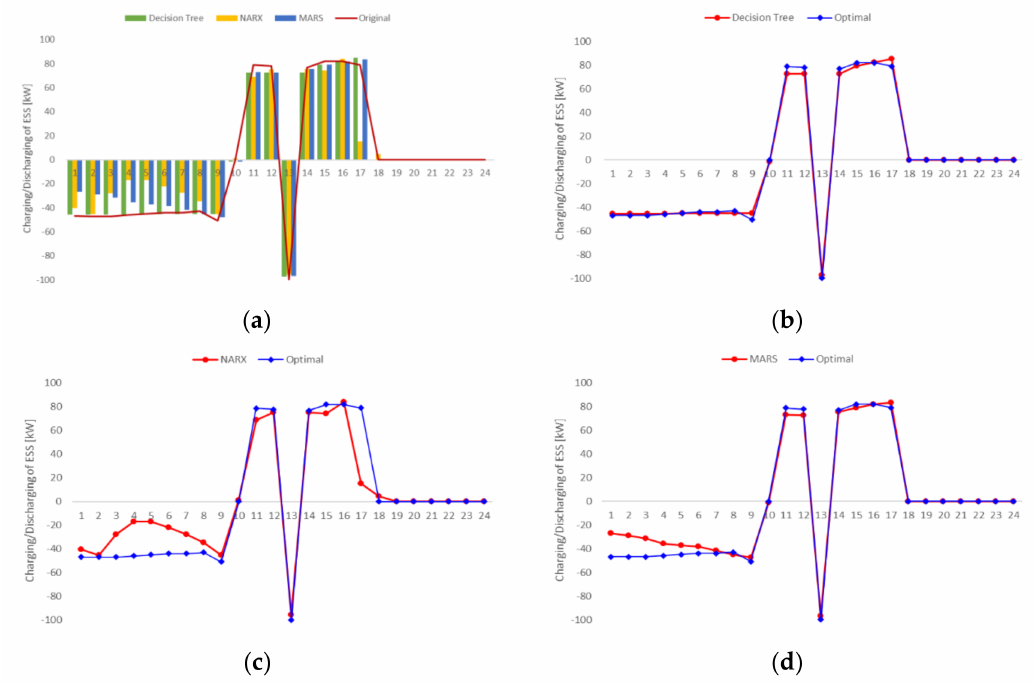
Figure 12. ( a ) Optimal schedule of ESS for minimization of operation cost at summer, ( b ) real and simulation results with DT, ( c ) real and simulation results with NARX, ( d ) real and simulation results with